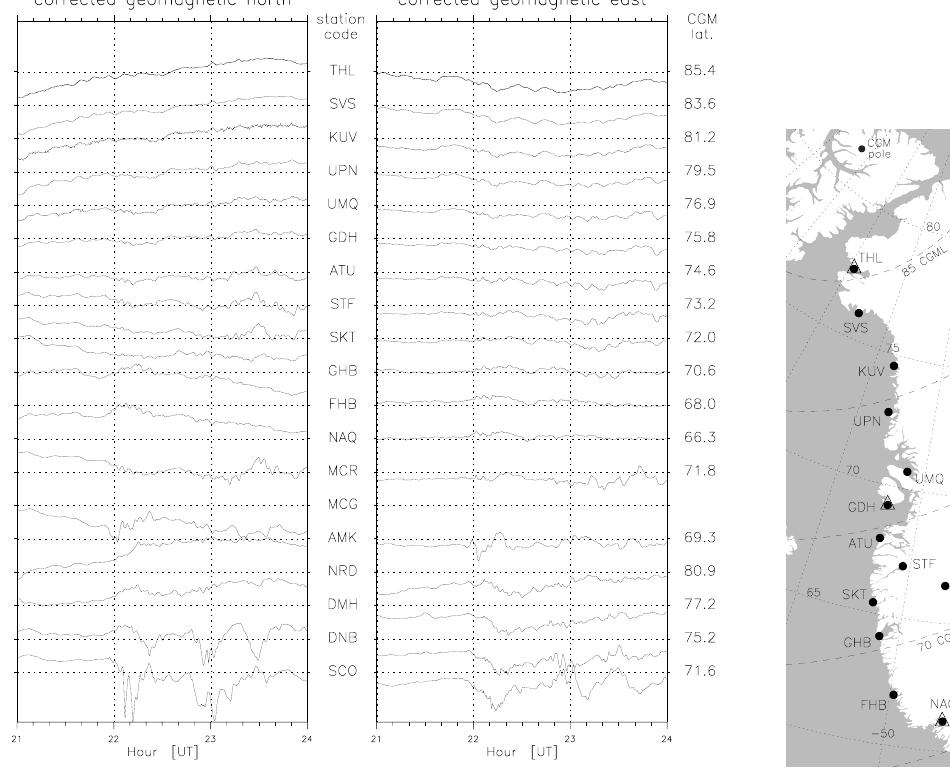
left and right panels of Fig. 3a display the corrected geo- magnetic north and east components, respectively. Figure